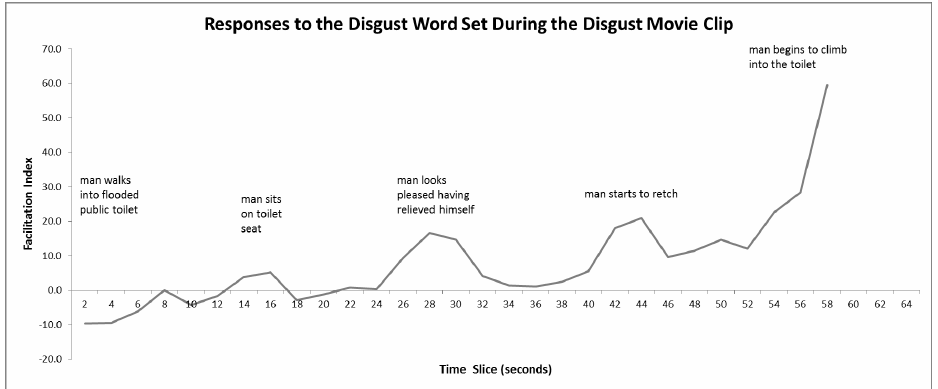
Figure 2. Three-point moving averages of facilitation indices for the Disgust word set whilst viewing the Disgust movie clip. Positive scores indicate disgust, negative scores indicate its opposite (attraction). The peak indices are also shown and a brief description of the content at that point in time. Analysis indicated that the facilitation indices at the seconds 28, 42 − 44, 54 − 58 are significantly different from zero (in each case p < 0.05).